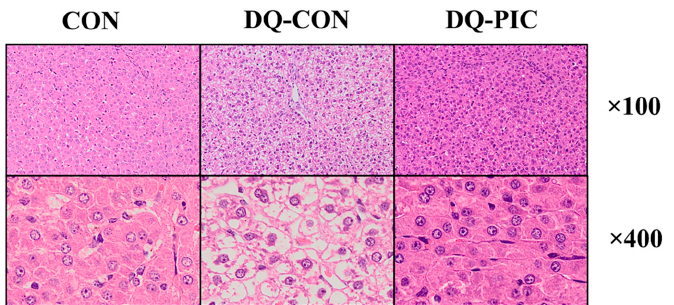
Figure 1. Representative images of hepatic tissue assessed by hematoxylin and eosin staining. CON, piglets were orally administrated vehicle solution (0.5% sodium carboxymethyl cellulose) and challenged with sterile saline; DQ-CON, piglets were orally administrated vehicle solution and challenged with diquat (10 mg/kg body weight); DQ-PIC, piglets were orally administrated piceatannol (80 mg/kg/day) and challenged with diquat (10 mg/kg body weight).